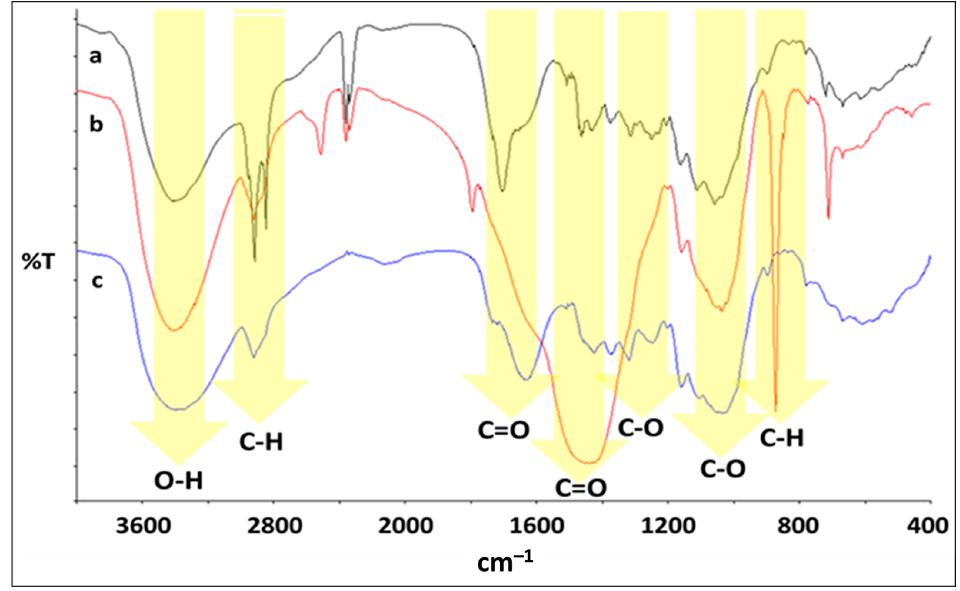
Figure 4. Plots of the FTIR spectrum: ( a ) SAMDBTF, ( b ) SACCMDBTF and ( c )